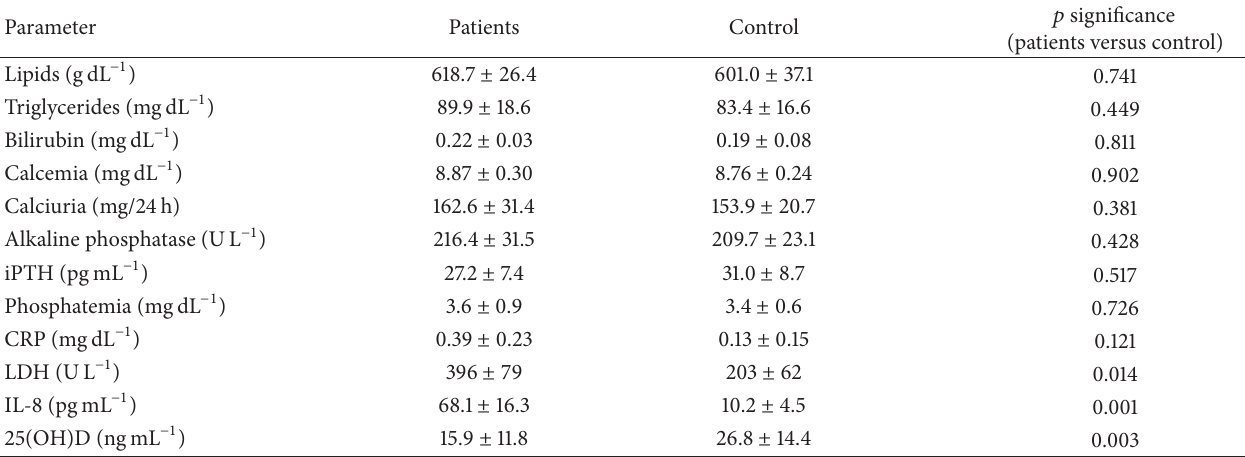
Table 2: Biochemical parameters.